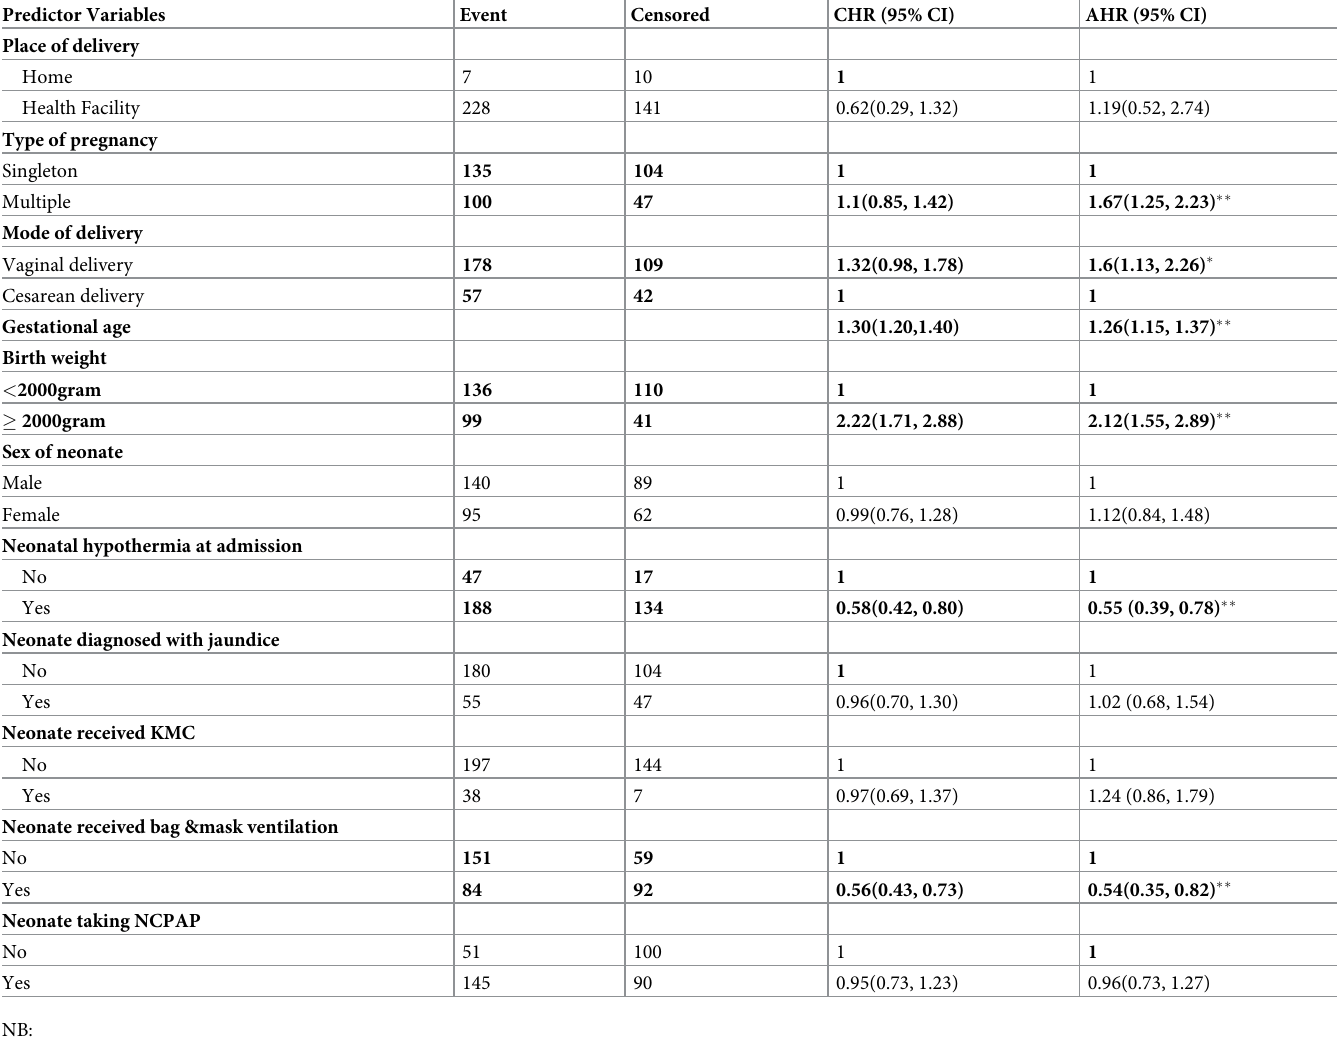
Table 3. Weibull hazard model for predictors of time to recovery among preterm neonates with RDS admitted in NICU at University of Gondar comprehensive specialized hospital from January 2016 to December 2018 (n = 386). Predictor